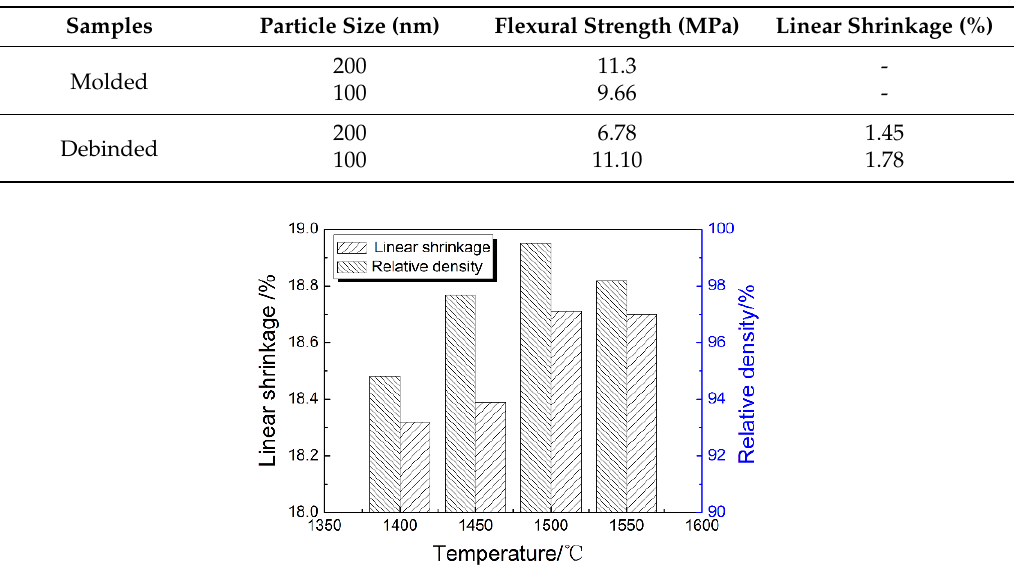
Figure 7. Linear shrinkage and density at different sintering temperatures of ZrO 2 ceramic nozzles with multi-micro holes using a 200 nm powder.